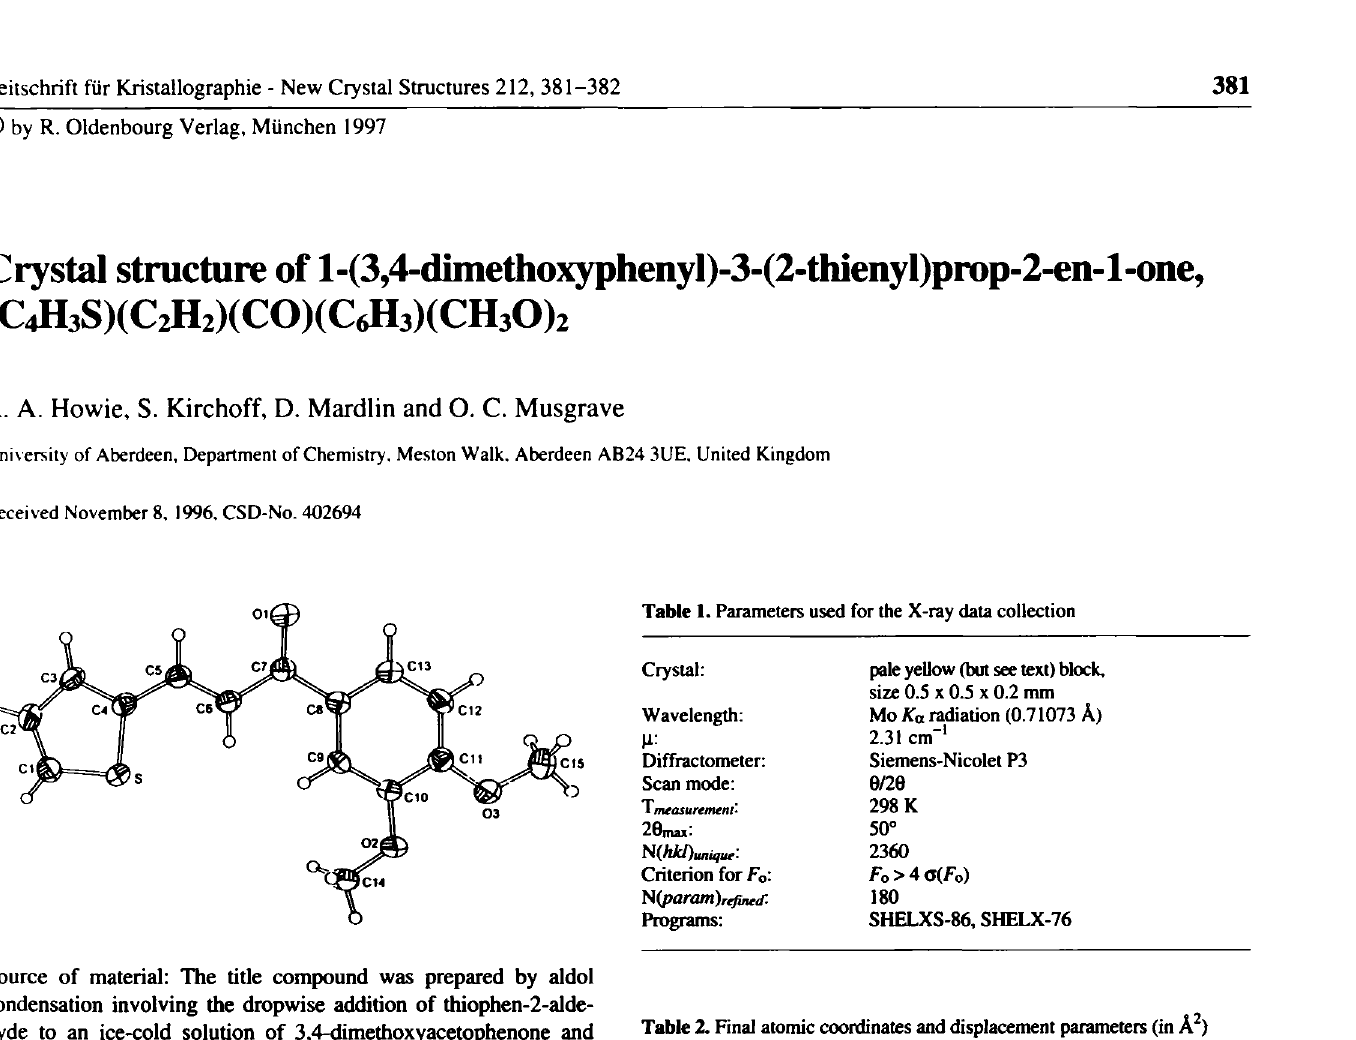
Table 2. Final atomic coordinates and displacement parameters (in Â 2